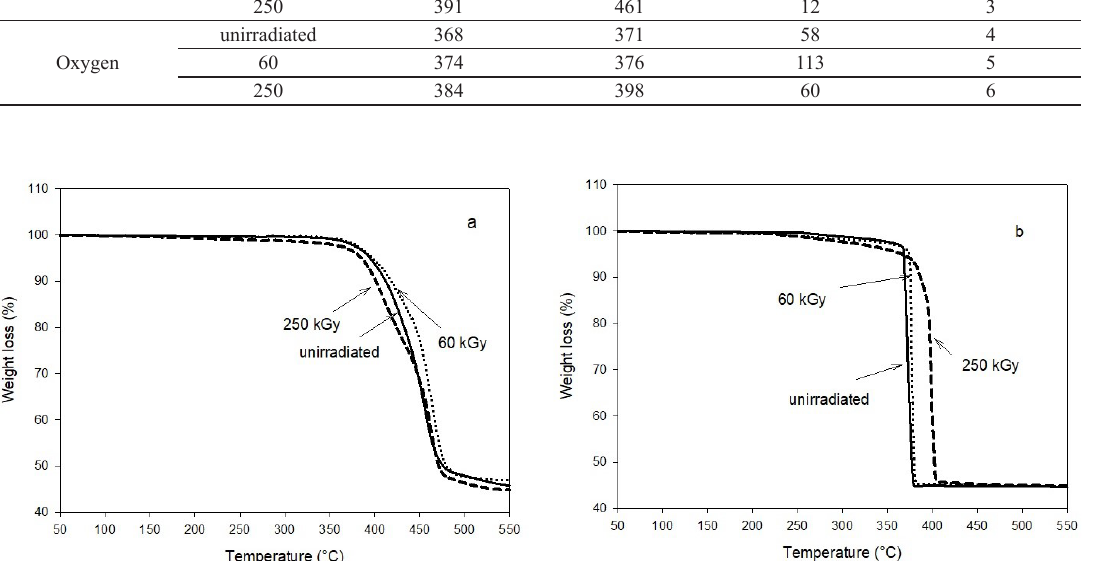
and b) O atmospheres. 2 2